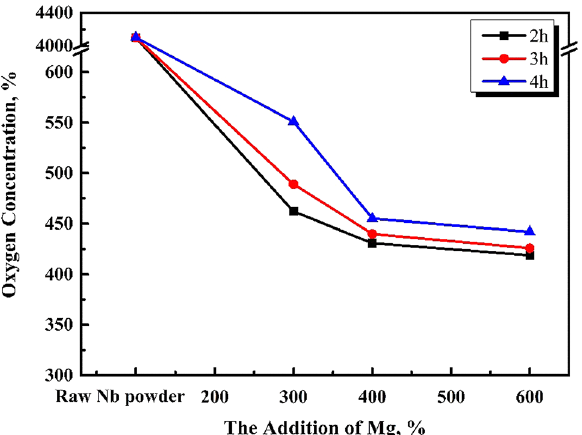
Figure 7. Effect of magnesium addition and reduction time at 1203 K on the oxygen content of pickling niobium